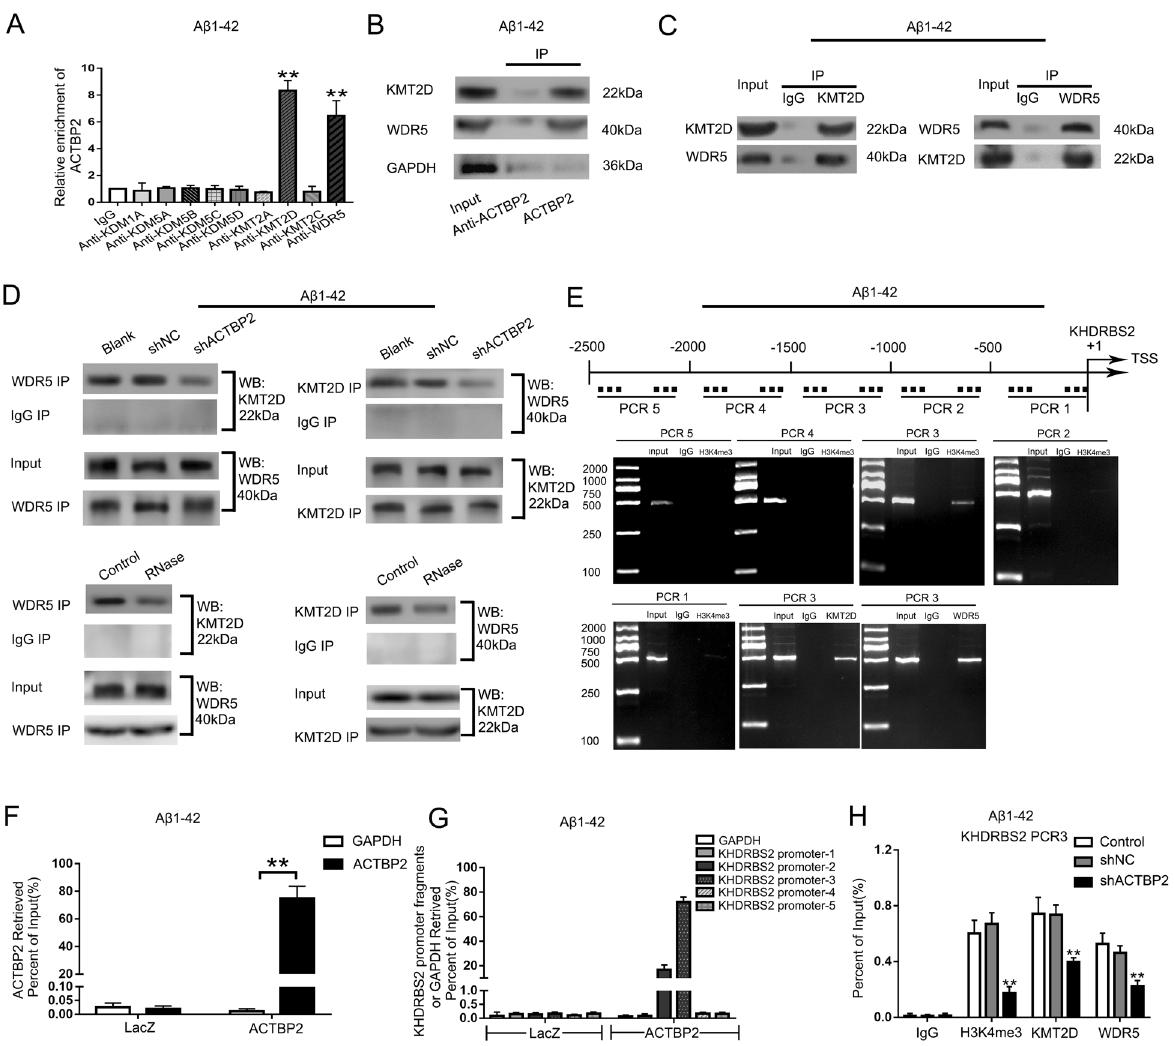
Fig. 3 ACTBP2 interacts with KMT2D and WDR5 methyltransferase modi fi cation complex in the KHDRBS2 promoter region in A β 1 – 42 - incubated ECs. A RNA immunoprecipitation experiments were performed using speci fi c antibodies. Relative enrichment was measured by qRT-PCR. Data are presented as mean ± SD ( n = 3). ** P < 0.01 versus anti-IgG group. B Western blot of the proteins from antisense ACTBP2 and ACTBP2 pull-down assays. C Co-immunoprecipitation detected the interaction of KMT2D and WDR5 in A β 1 – 42 -incubated ECs. The speci fi c immunoprecipitation of WDR5 and KMT2D was con fi rmed by western blot. D Co-immunoprecipitation assays were performed to detect the interaction between KMT2D and WDR5 after ACTBP2 knockdown (top) or RNase treatment (bottom). E KHDRBS2 DNA fragments were detected in the chromatin sample immunoprecipitated from A β 1 – 42 -incubated ECs using the antibody against H3K4me3, KMT2D, or WDR5. F , G ChIRP analysis of ACTBP2 binding to the KHDRBS2 promoters is shown. F The fold enrichment of ACTBP2 in ACTBP2 ChIRP analysis with DNA antisense oligos (asDNA) speci fi c for ACTBP2; G the fold enrichment of KHDRBS2 promoter fragments in ACTBP2 ChIRP analysis. LacZ RNA used as the mock control. ( n = 3) H H3K4me3, KMT2D, and WDR5 levels in KHDRBS2 promoter region from 1500 to 1000 bp upstream of the transcription start site (TSS) were decreased after ACTBP2 knockdown in A β 1 – 42 -incubated ECs. Data are presented as mean ± SD ( n = 3). ** P < 0.01 versus shNC